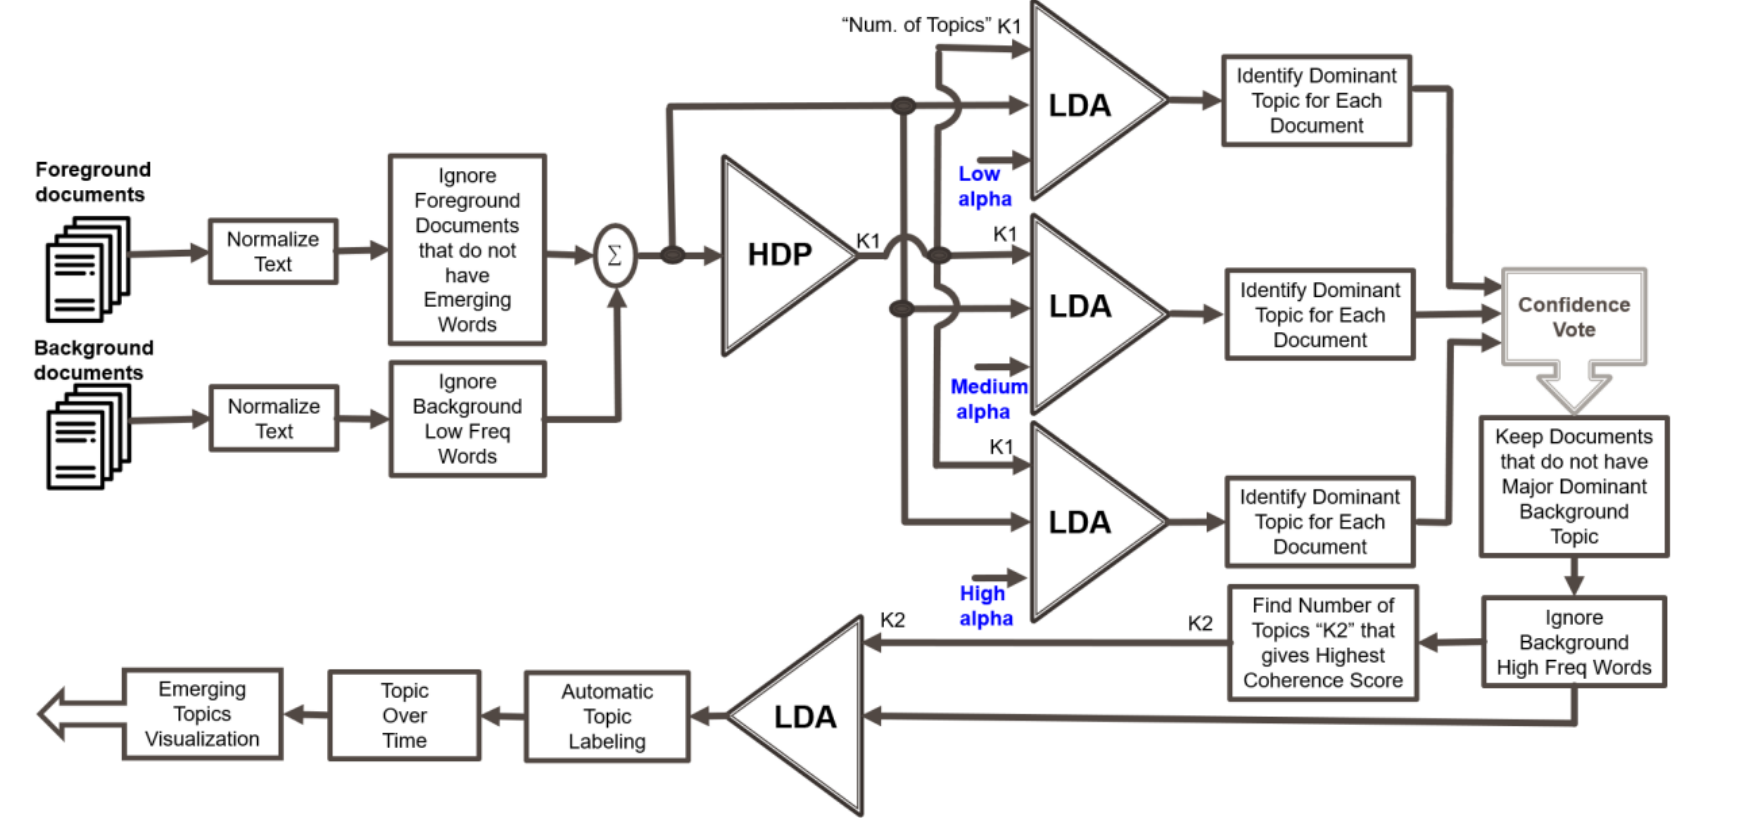
Figure 9. Emerging topic detection filtered-LDA framework #1.